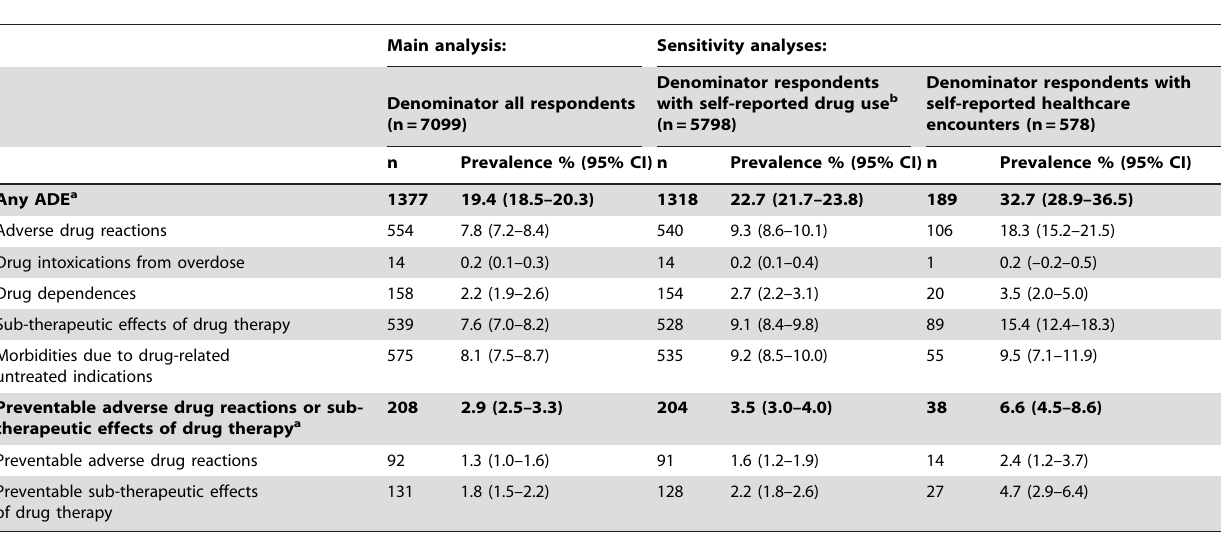
Table 3. Sensitivity analyses for the 1-month prevalence of self-reported ADEs and preventable ADEs, varying the denominator.